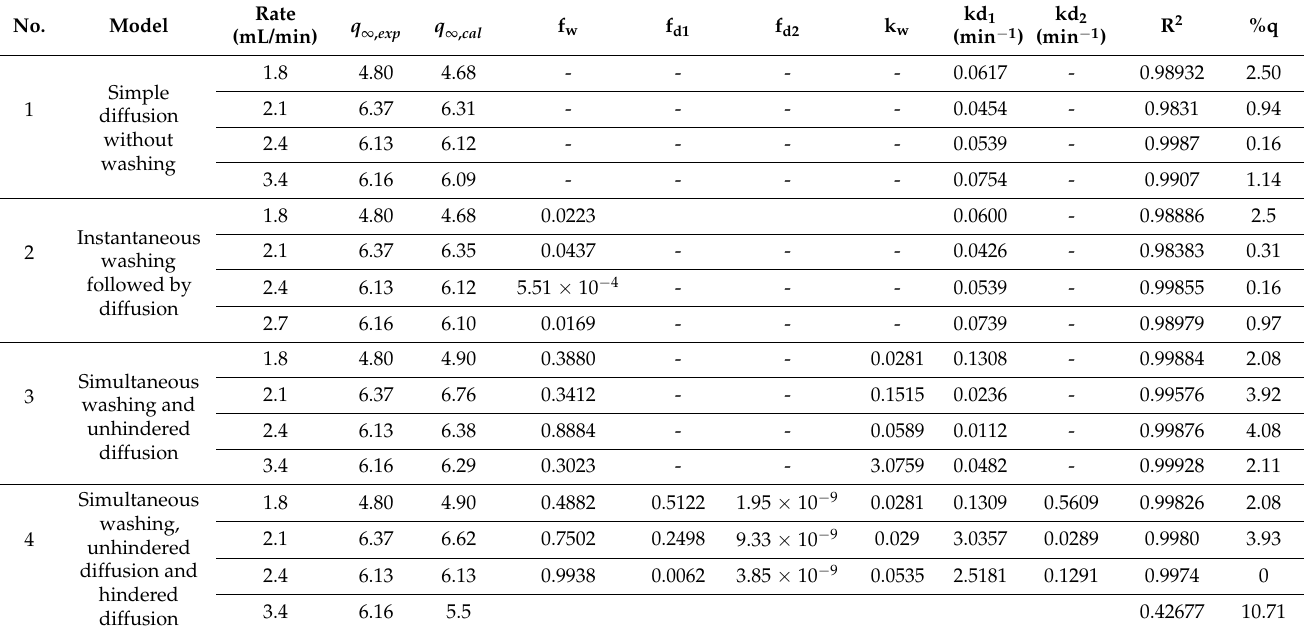
Table 5. Kinetic parameters of pomelo peel essential oil extraction by steam